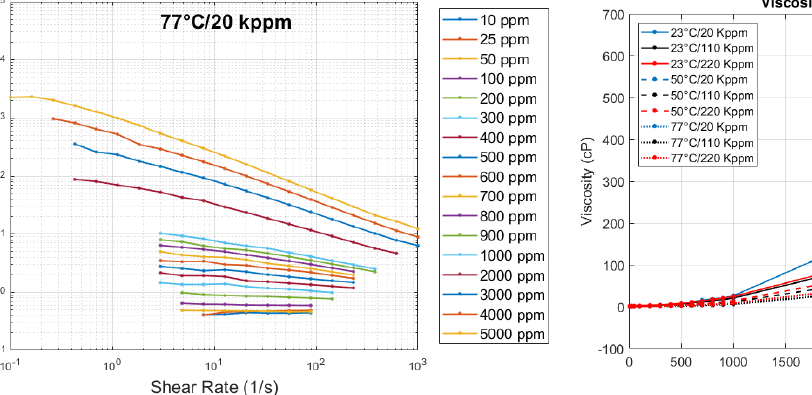
Figure 9: Flow curves graph at 77 ∘ C and 20,000 ppm of NaCl